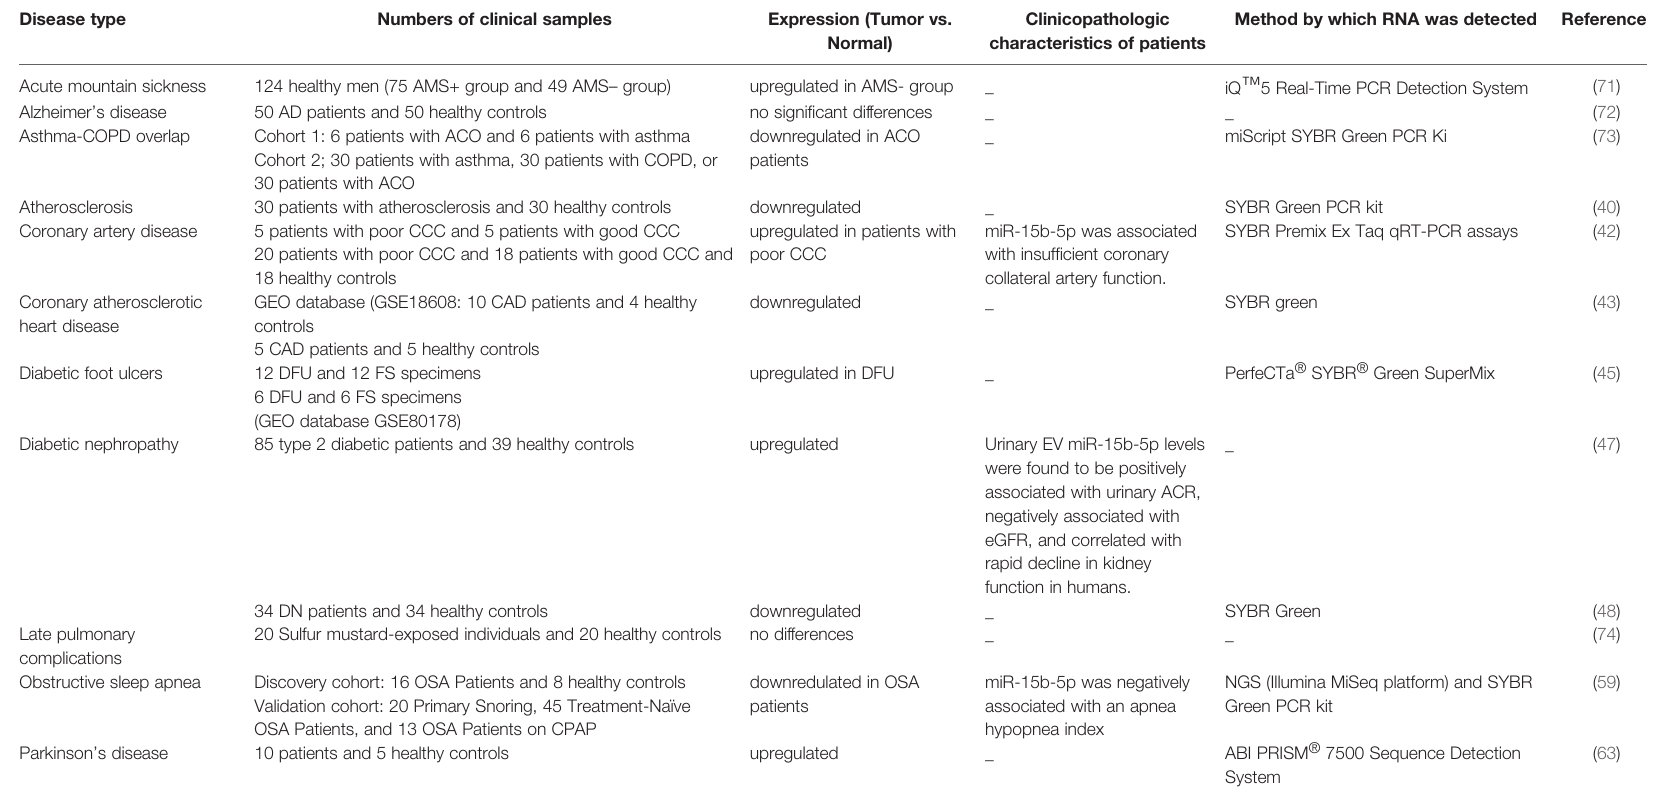
TABLE 6 | Summary of human studies on the role of miR-15b-5p in non-malignant conditions (CAD, coronary atherosclerotic heart disease; CCC, coronary collateral circulation; ACR, albumin-to-creatinine ratio; eGFR, Estimated Glomerular Filtration Rate; AMS, Acute mountain sickness; COPD, chronic obstructive pulmonary disease; ACO, asthma-COPD overlap; DN, diabetic nephropathy; OSA, obstructive sleep apnea;